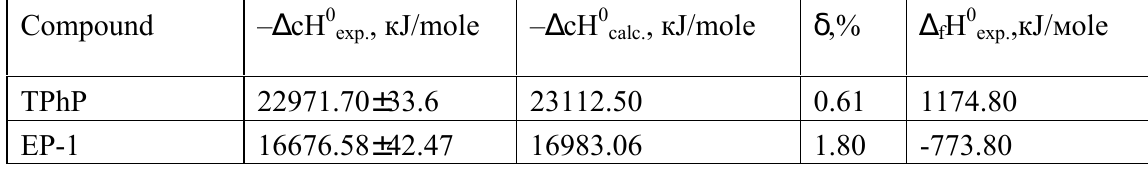
Table 1: Experimental and calculation magnitudes of combustion and formation enthalpies